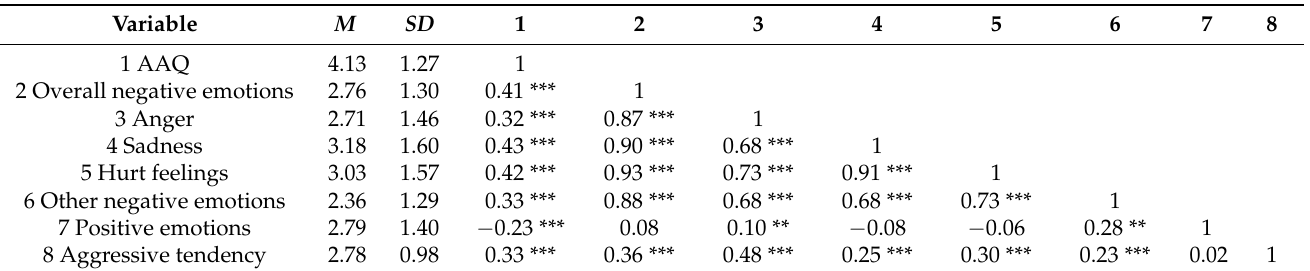
Table 1. Correlation results between trait acceptance, aggressive tendency and emotions.